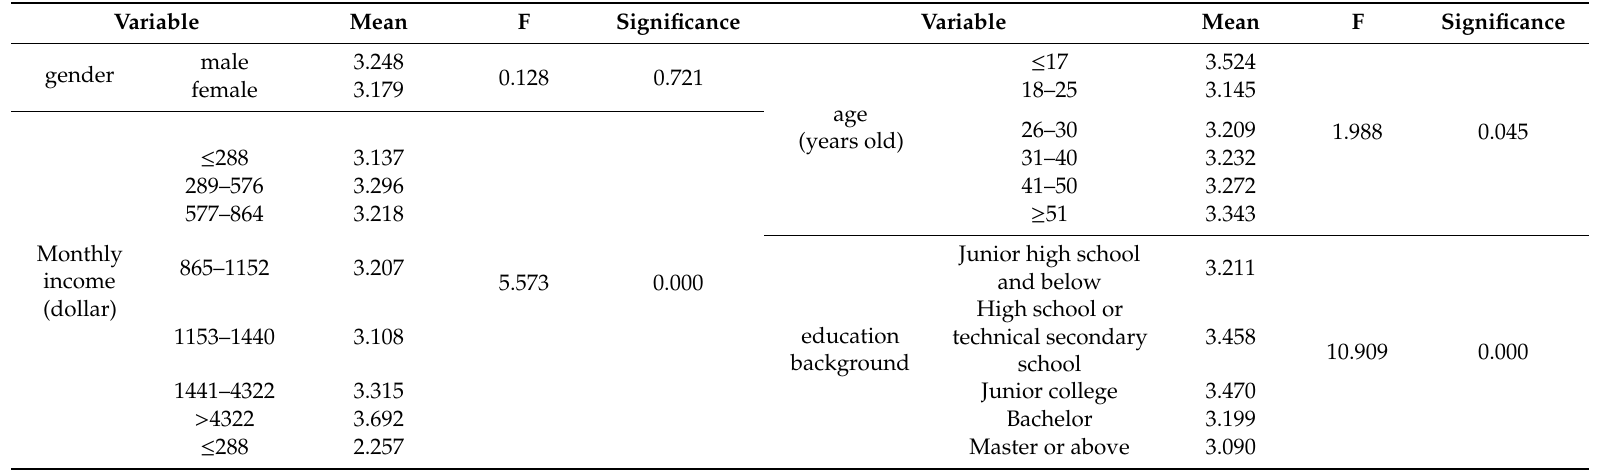
Table 3. Analysis of the influence of gender, age, education background, and monthly income on waste-sorting behavior of urban residents.